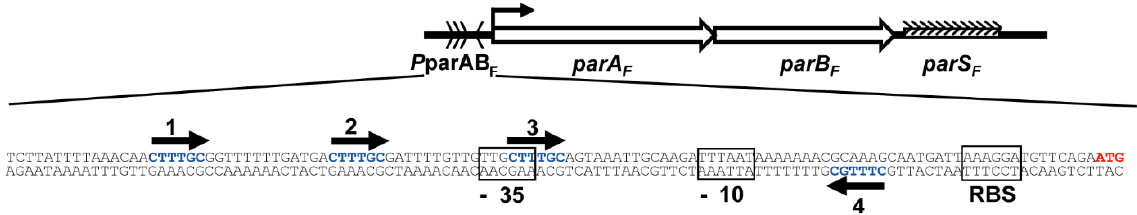
Figure 1. The parABS F ( sopABC ) partition locus of the plasmid F. Top: Schematic representation of the parABS F locus. The parA F and parB F genes, the promoter region ( P parAB F ) and the cis -acting parS F site are drawn at scale over 3-kbp. The arrow represents the transcriptional start point. Arrowheads in P parAB F display the positions and orientations of the hexamer 5 ′ CTTTGC motifs. The arrowheads in the parS F centromere site represent the twelve 43-bp tandem repeats containing the ParB F binding sites. Bottom: Nucleotide sequence of the P parAB F promoter region. The parA F start codon and the hexamer motifs are labeled in red and blue, respectively. The − 10 and − 35 promoter motifs and the ribosome binding site (RBS) are indicated by boxes.